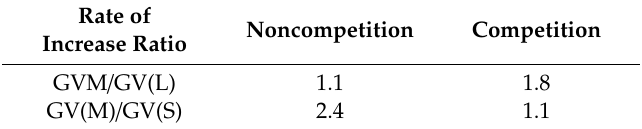
Table 4. Rates of increase ratios of GV(M) to GV(L) and of GV(M) to GV(S) in